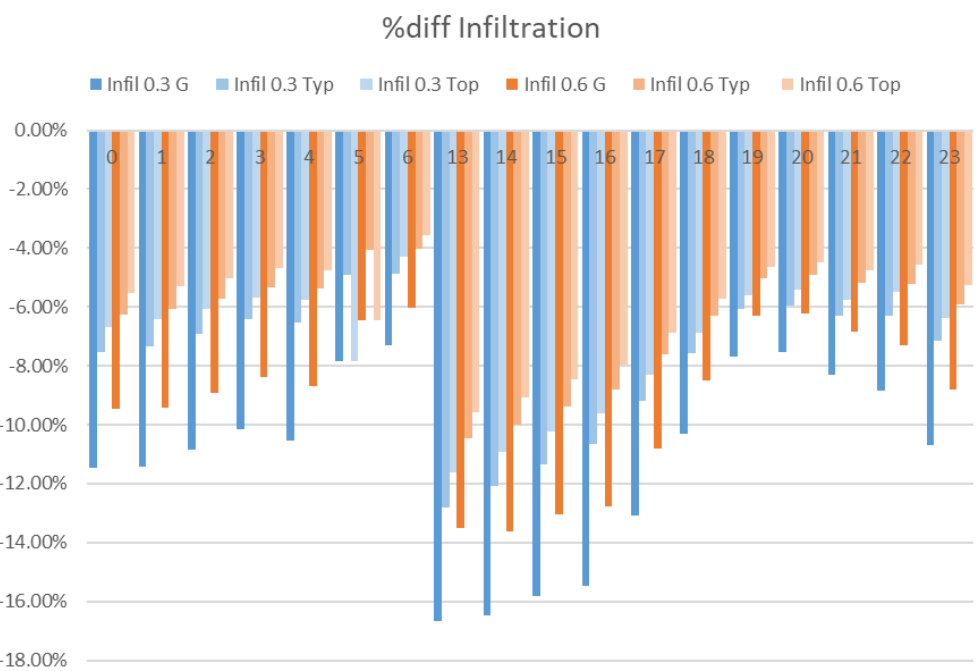
Figure 5. Hourly Median of percentage difference in total electricity after applying infiltration parameters. “Infil 0.3 G”—the data of the ground floor for the simulation run with 0.3 ach infiltration rate; and so on.